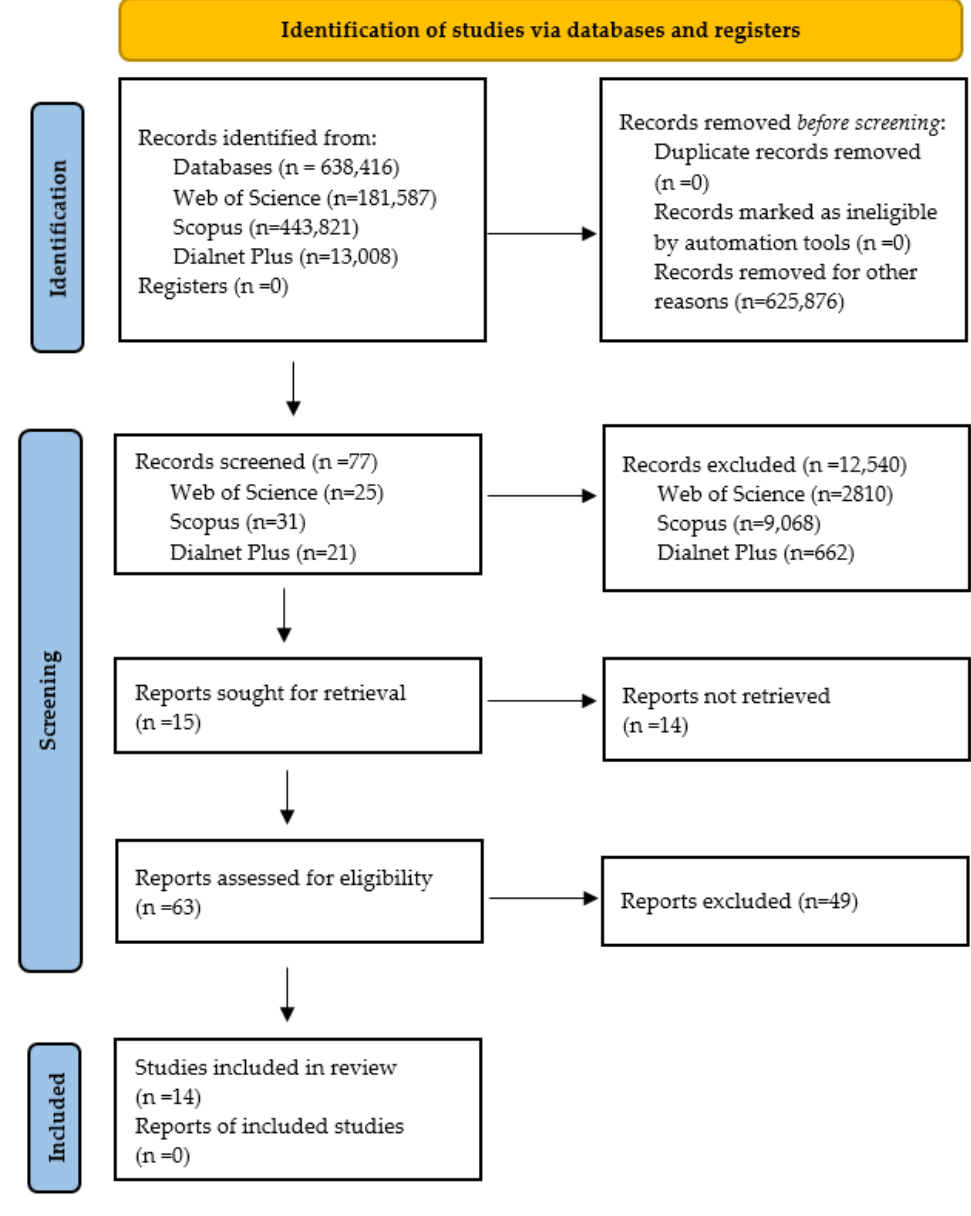
Figure 2. Selection Criteria Flowchart. Table 1. Procedure for selecting articles from the structured search in the primary databases.